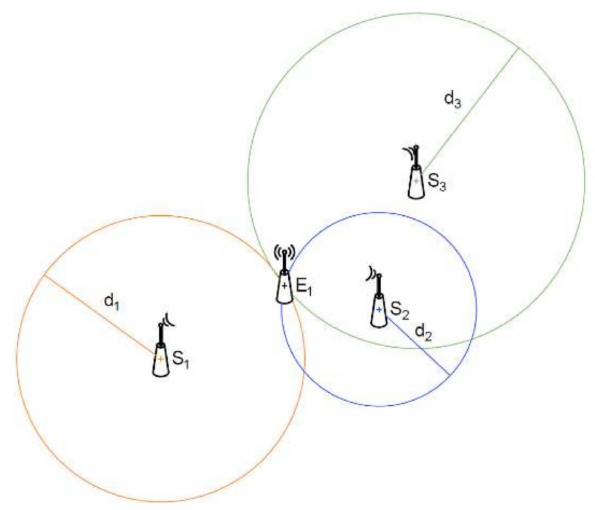
Figure 1. Illustration of the effector location by radio sensors, using